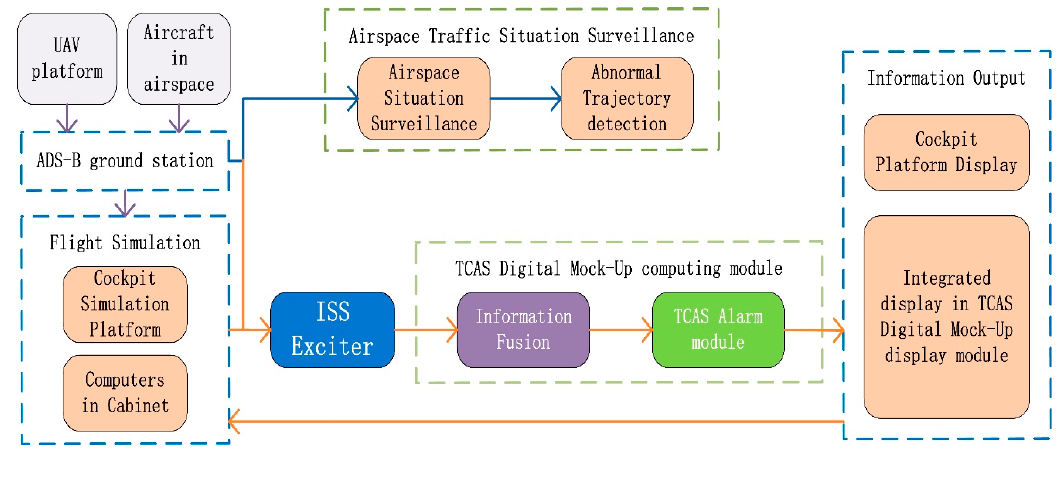
Figure 6. System design block diagram.